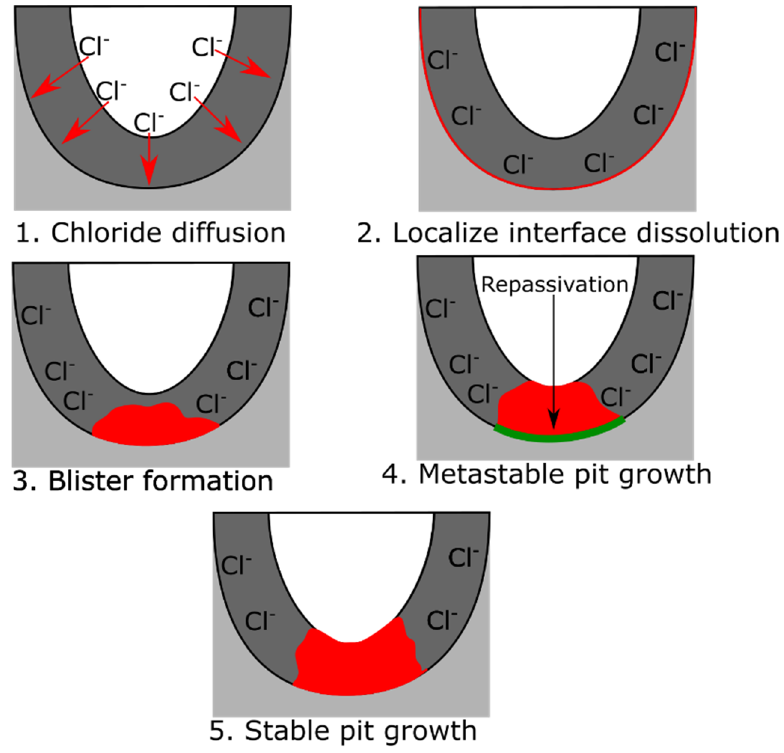
Figure 2. Schematic illustration of the pitting corrosion mechanism of anodic oxide films on aluminium substrates based on the work by McCafferty [34].